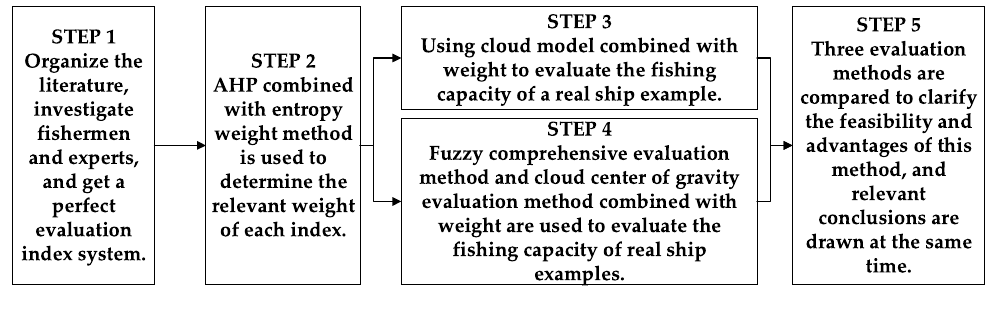
Figure 1. Method flow chart of this